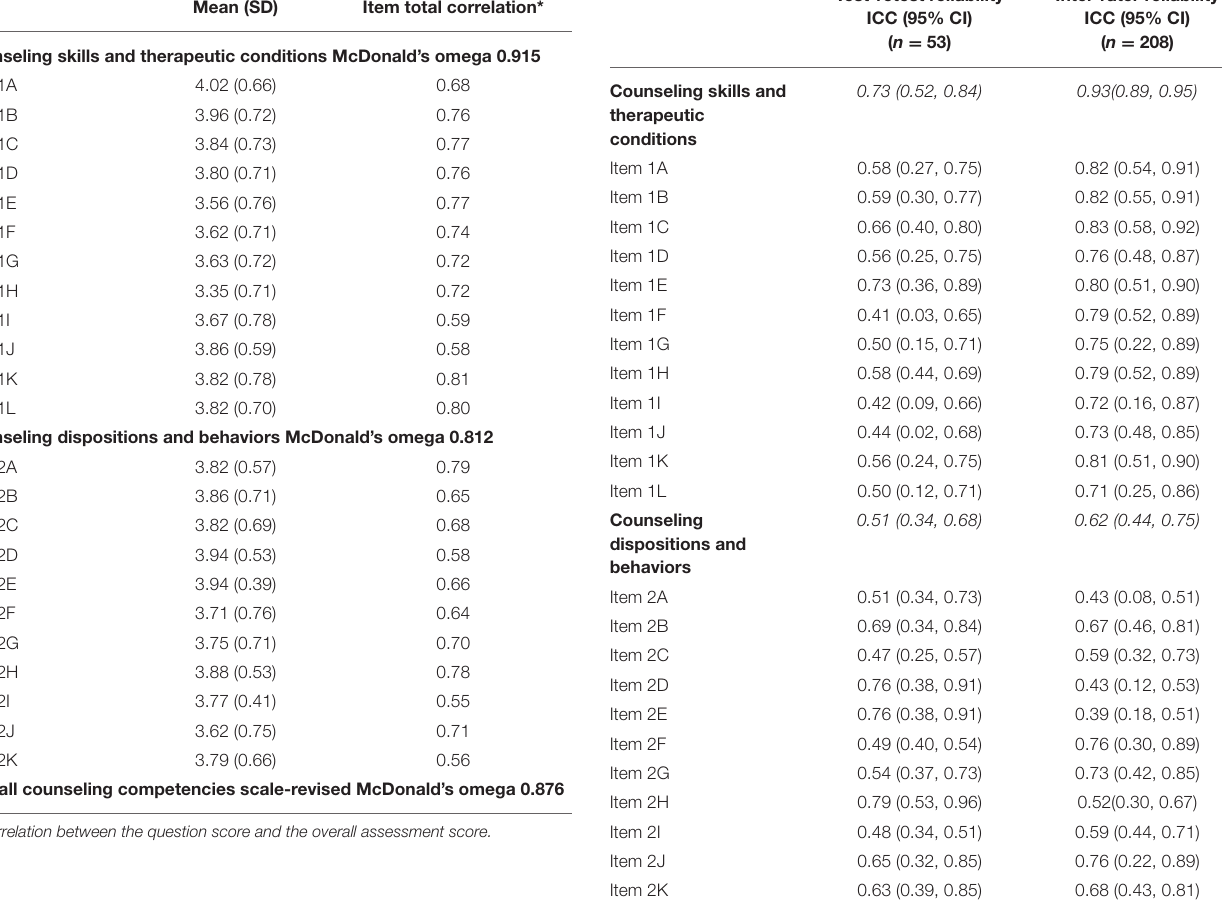
TABLE 4 | Descriptive and reliability statistics of the counseling competencies scale-revised. Mean (SD)